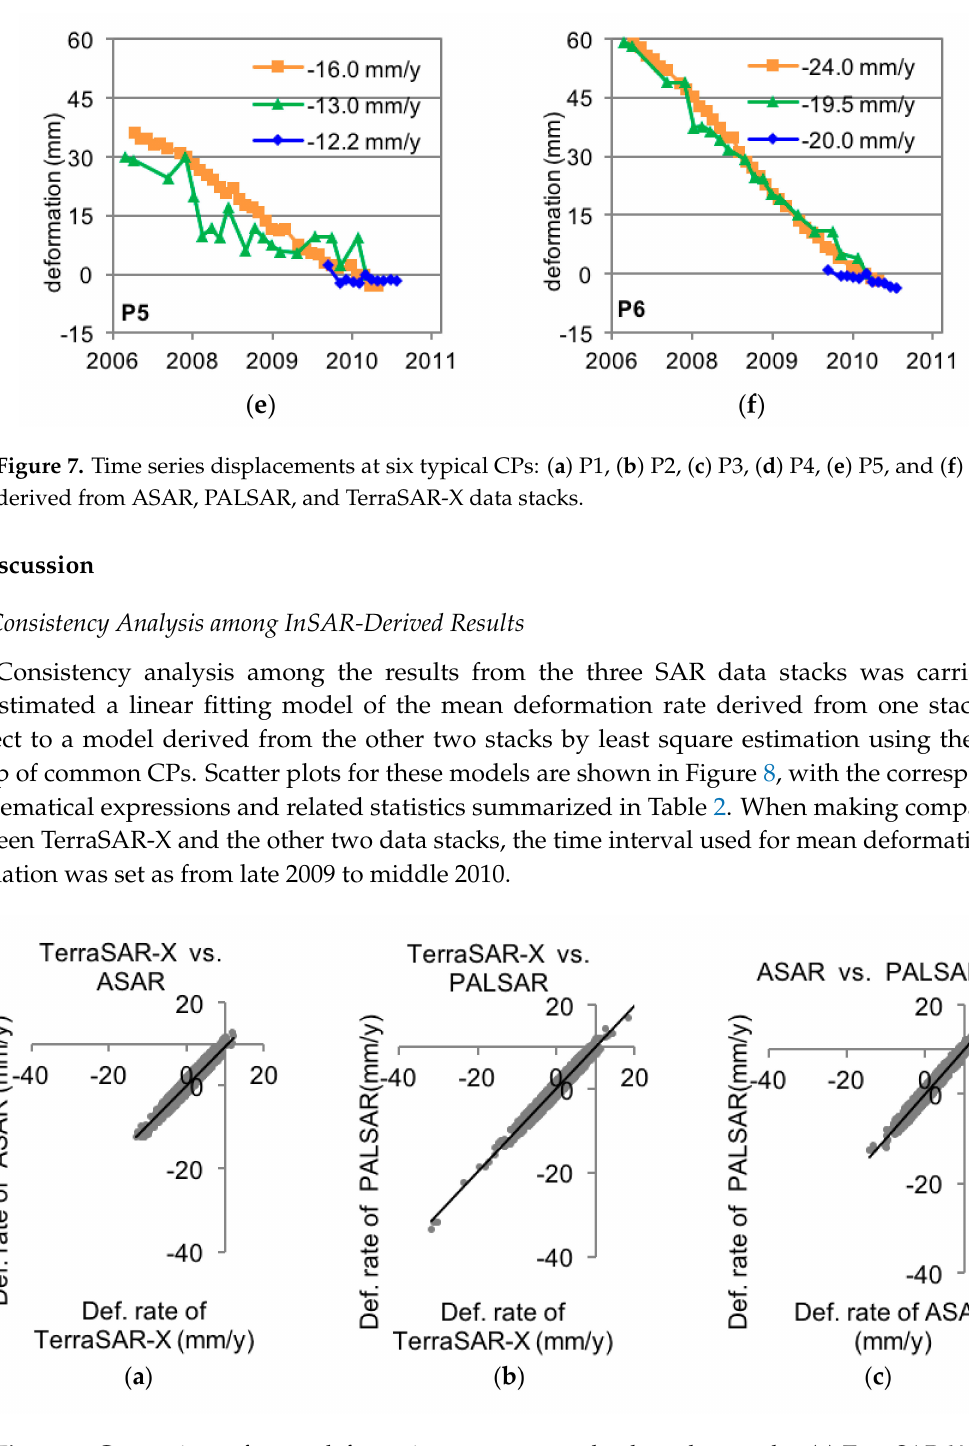
Figure 8. Comparison of mean deformation rates among the three data stacks: ( a ) TerraSAR-X vs. PALSAR, ( b ) TerraSAR-X vs. ASAR, ( c ) ASAR vs.